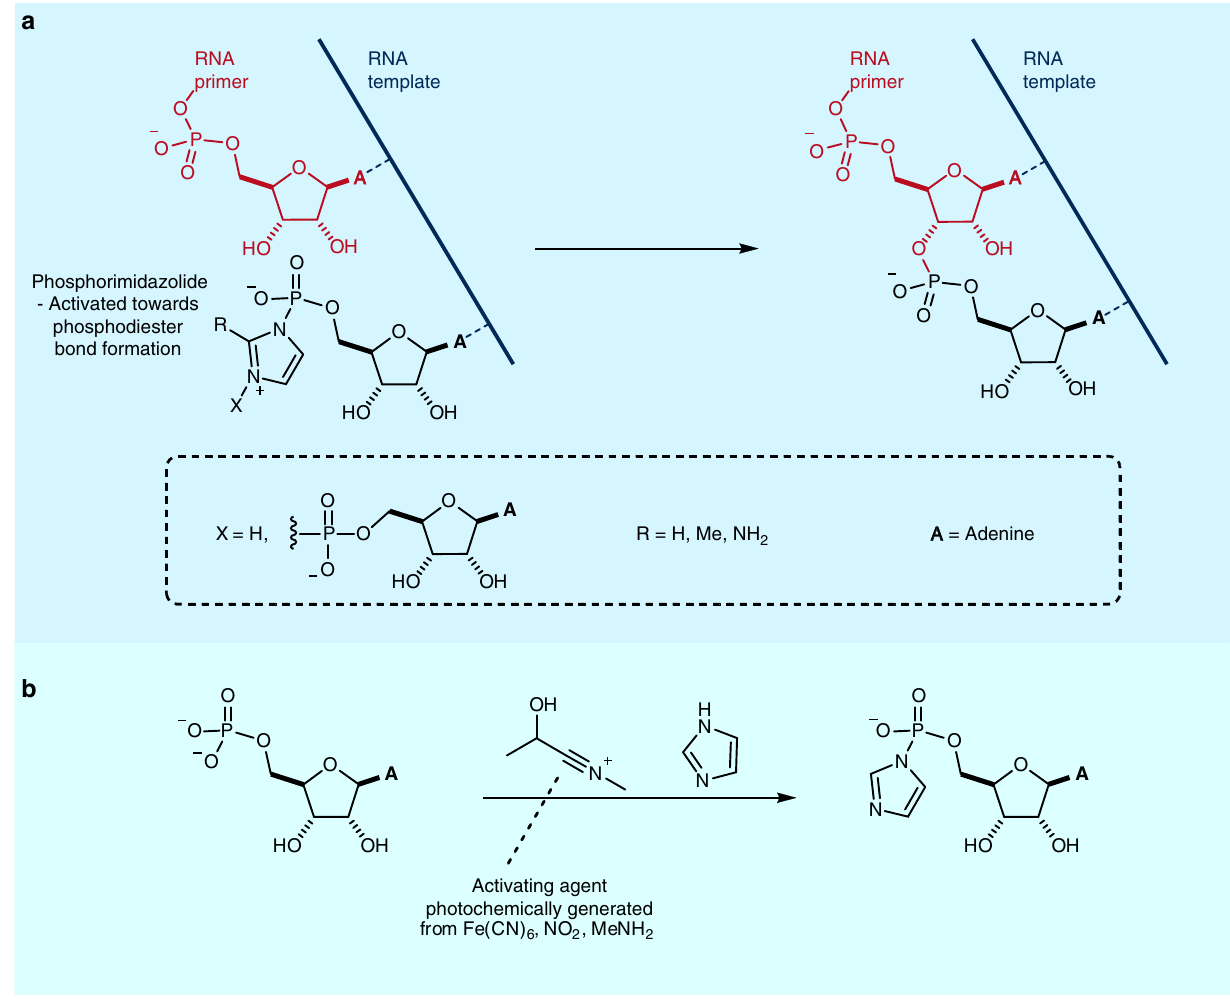
Fig. 1 Phosphorimidazolide activation of nucleotides. a Phosphorimidazolide mediated non-enzymatic template-directed RNA primer extension. b Prebiotically plausible synthesis of adenosine-5 ′ -phosphorimidazolide (R = H), using a photochemically generated activating